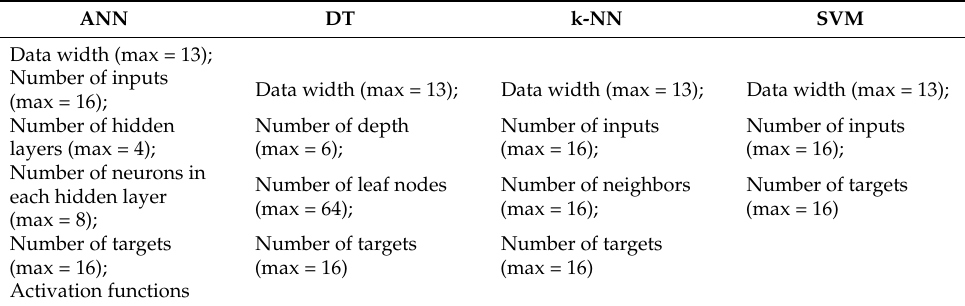
Figure 1. Block diagram of the MLoF system architecture. Table 1. Configurable